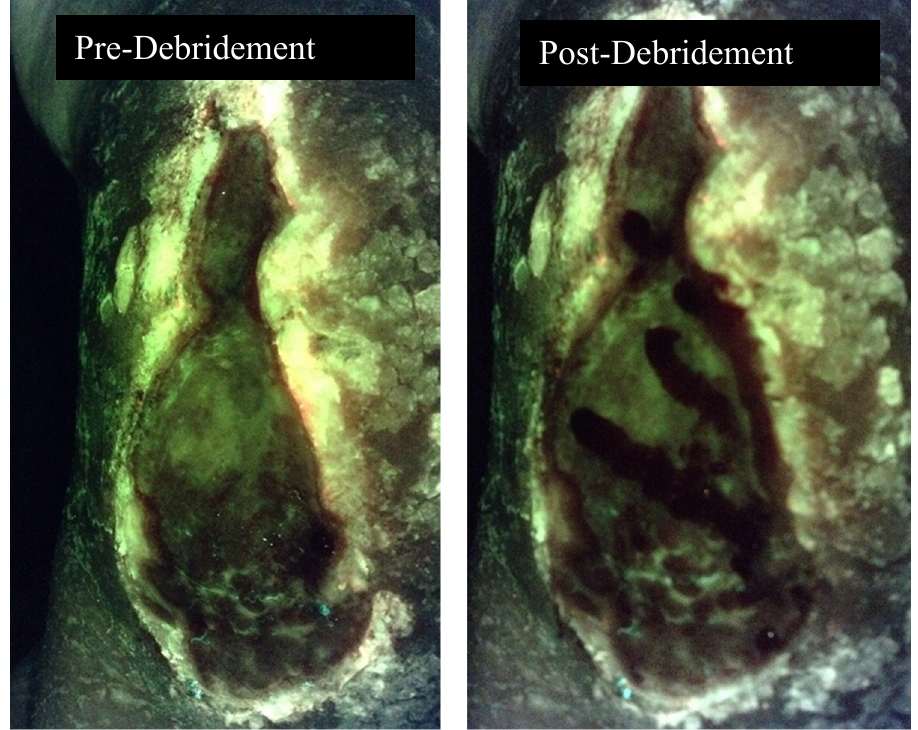
Figure 2. Fluorescence image pre and post debridement of a medical gaiter venous leg ulcer demonstrating the absence of fluorescence following debridement.